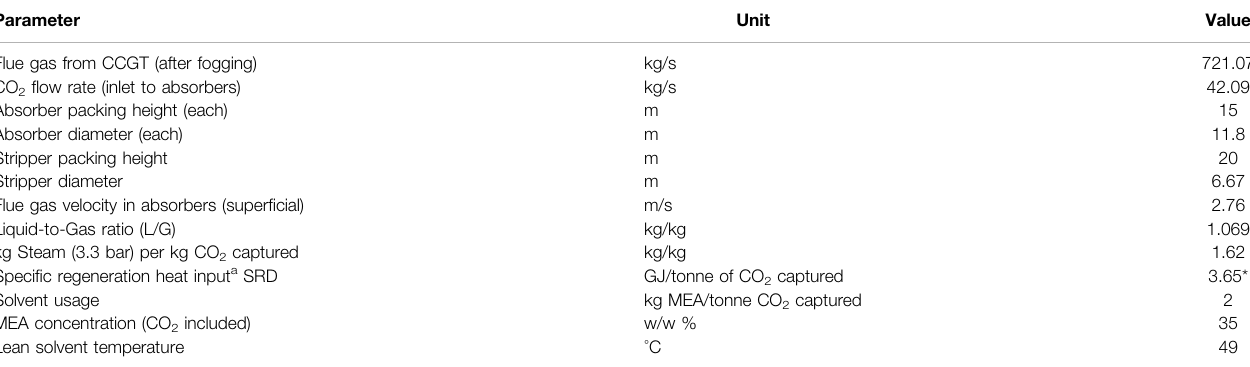
TABLE 1 | Basic process values of the Sherman PCC FEED study (Elliott et al., 2021a).